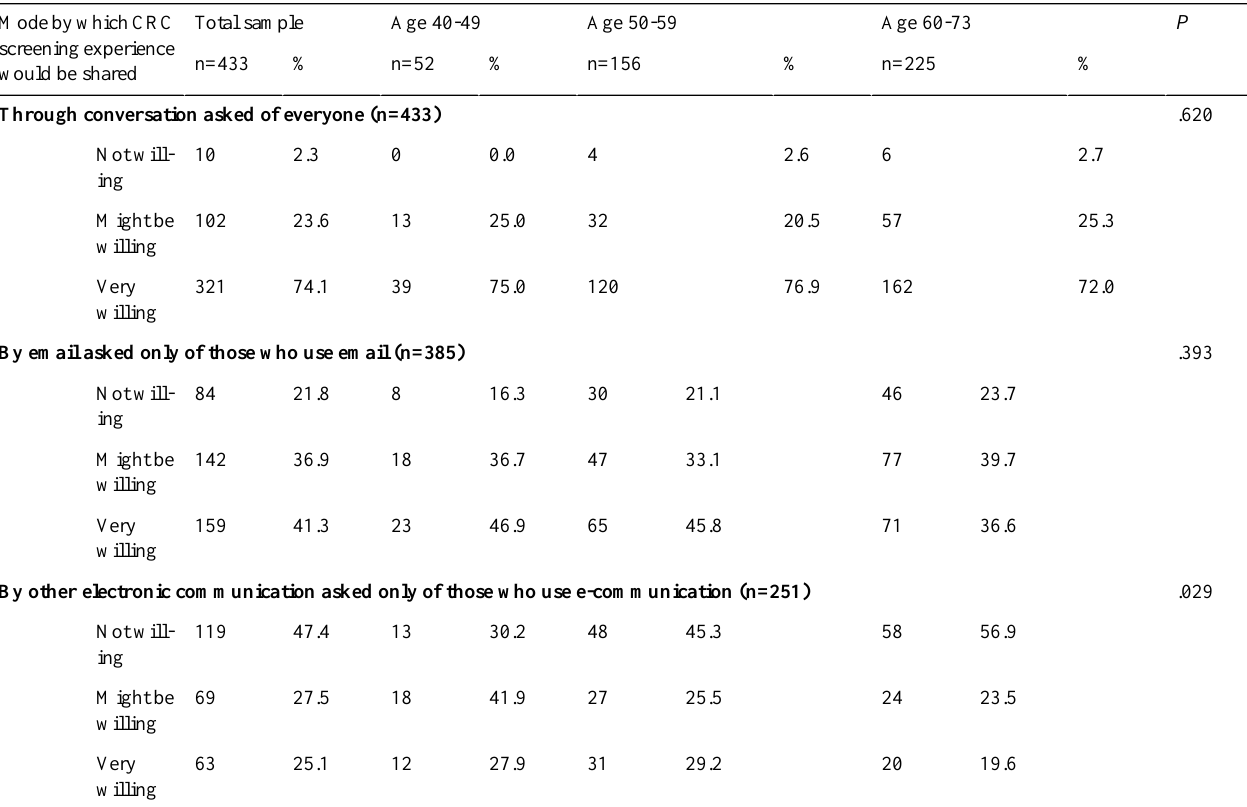
Table 3. Willingness to share personal CRC screening experience with friends and family and preferred